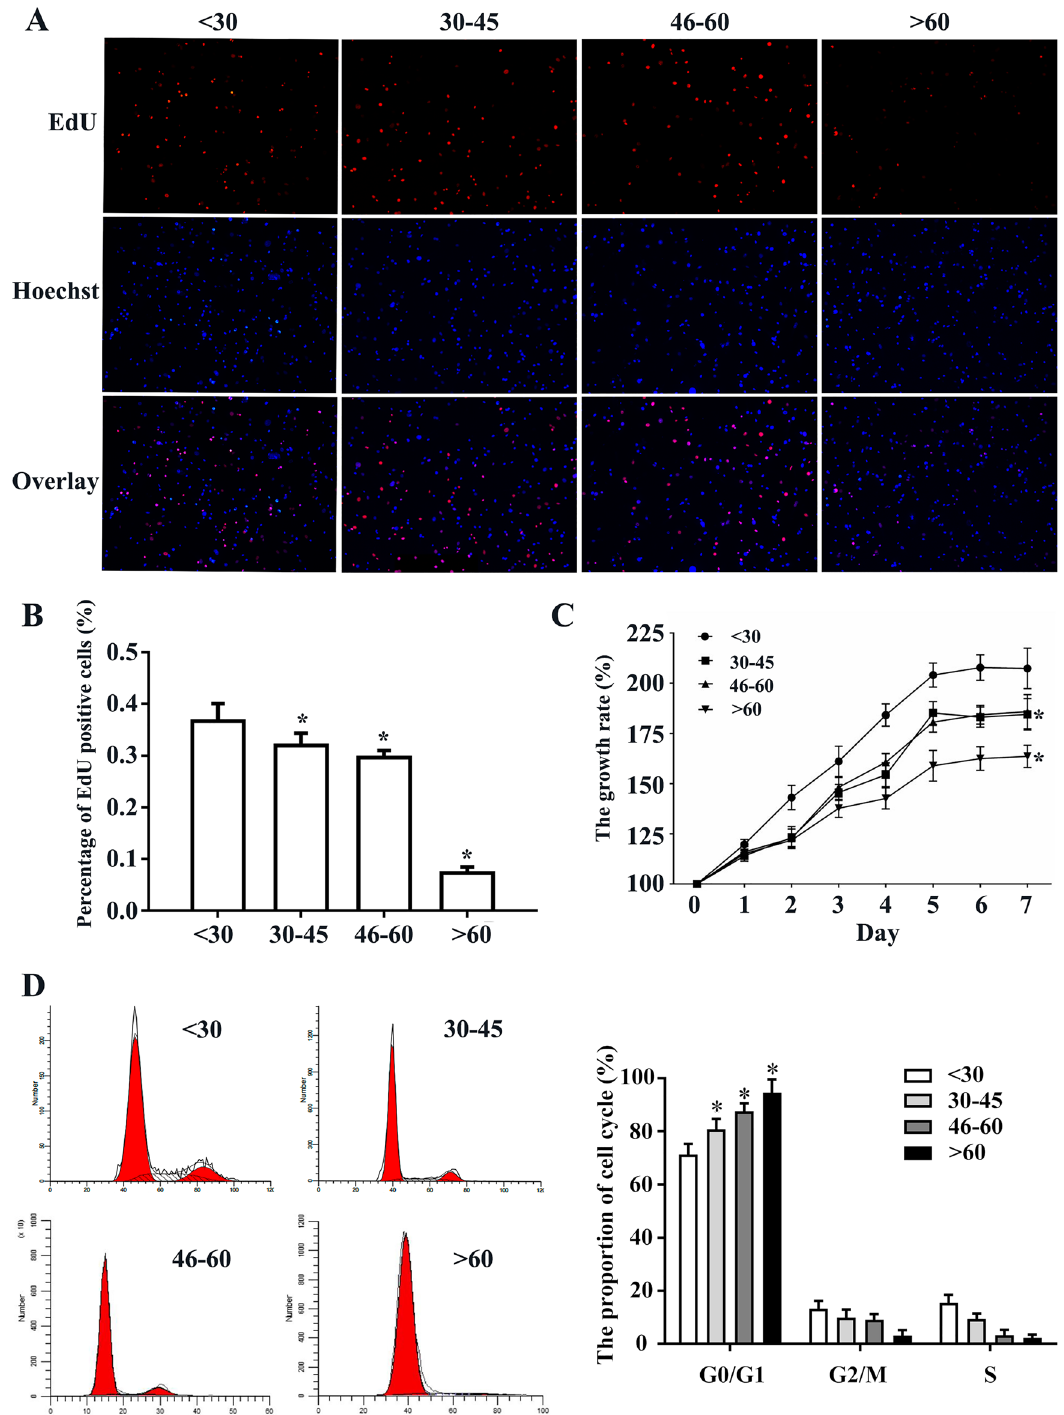
Figure 2. Cell cycle analysis and proliferation rates of hBMHCs obtained from individuals of different age groups. ( A ) Representative image of the EdU staining. ( B ) Graphical representation of the enumeration of EdU positive cells in each group. ( C ) CCK-8 assay was performed to determine growth rates in cells obtained from individuals of different ages. ( D ) Representative image of the cell-cycle and graphical representation of the enumeration of cell-cycle in each group. * p < 0.05: when compared with the < 30 years group. Scale bar = 200